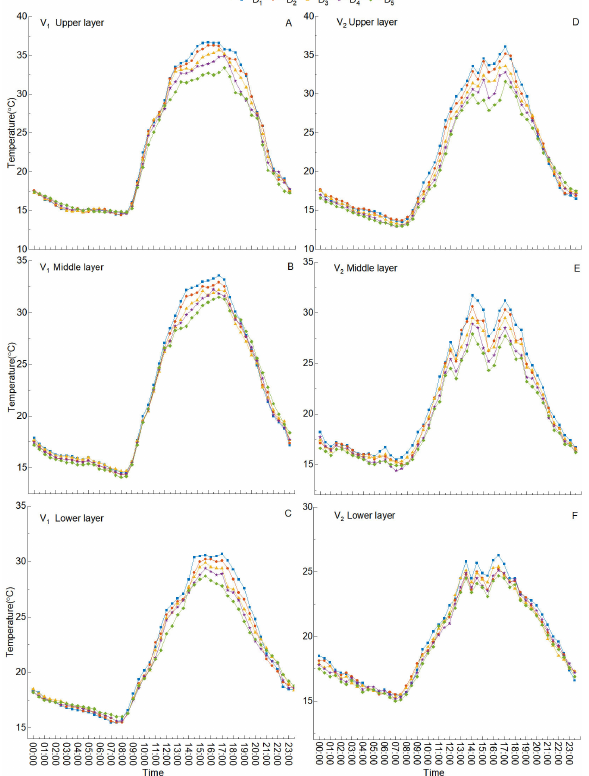
Figure 5. Effects of planting density on canopy temperature in uniformly sown winter wheat. V 1 , Xindong 50. V 2 , Sangtamu 4. ( A – C ) refer to the upper, middle, and lower layers of Xindong 50, respectively, whereas ( D – F ) indicate the upper, middle, and lower layers of Sangtamu 4,